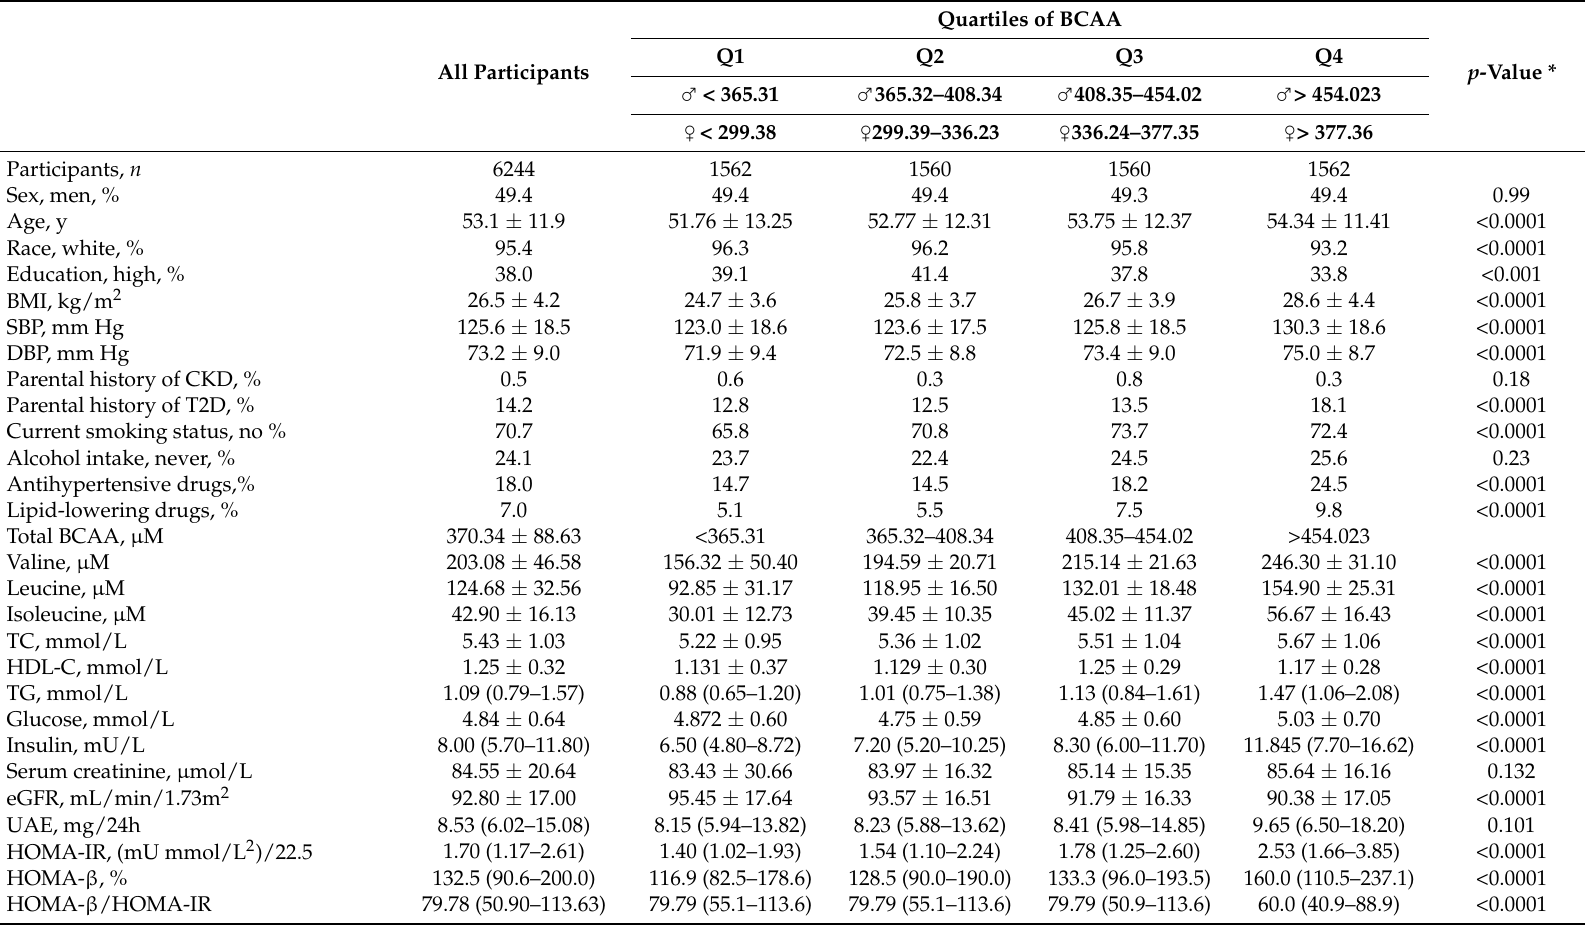
Table 1. Participant characteristics according sex-stratified quartiles of BCAA in participants free of type 2 diabetes at baseline ( n =